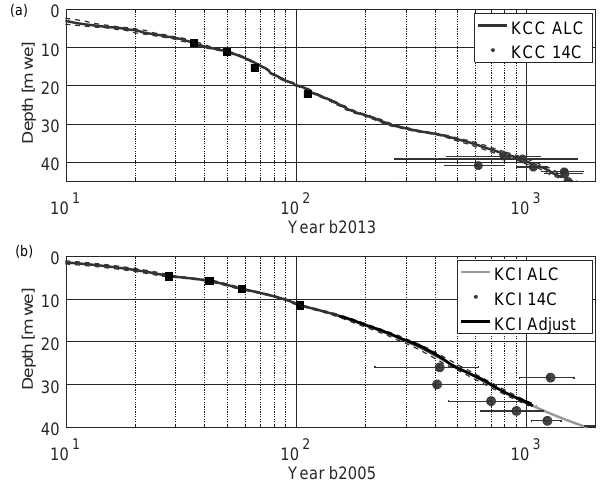
Figure 4. Age–depth relations over the last 1000 years for KCC (top) and KCI (bottom). Age is plotted on a logarithmic axis, to- gether with the according estimates of maximum dating uncertainty (dashed lines) and 14 C age constraints (with 1 σ range) for KCC and KCI. Also shown is the adjusted age scale of KCI based on the stable water isotope time series comparison (solid black line, within less than 15 years of the original dating and thus hardly dis- tinguishable here; see text). Absolute dating horizons used roughly within the last 100 years (see text) are shown as black squares. Note that the KCI chronology is based on a simple extrapolation below 26mw.e. and has large uncertainty beyond the last 1000 years (thus indicated as light grey line